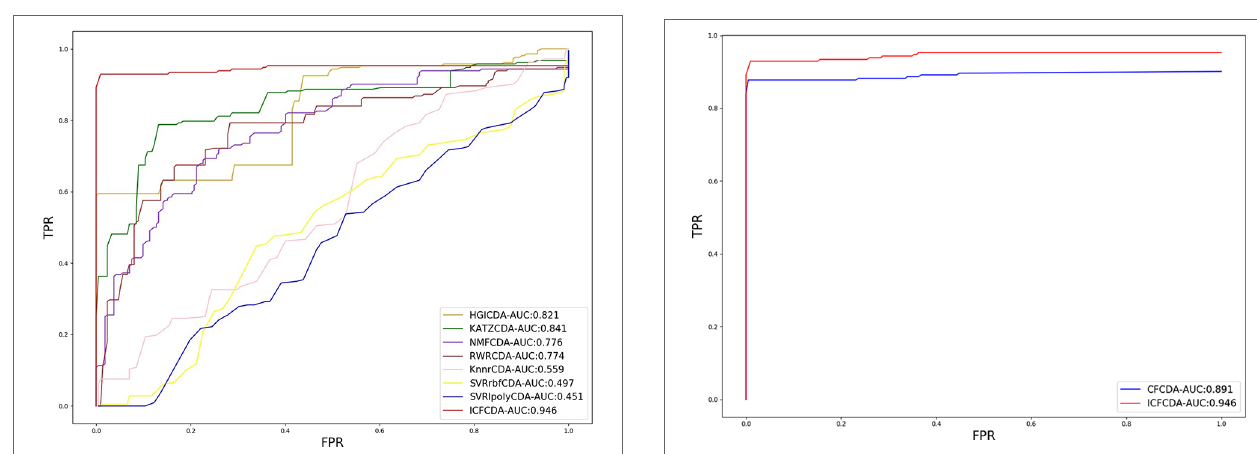
FIGURE 2 | The AUC value of ICFCDA compared with other computational methods.